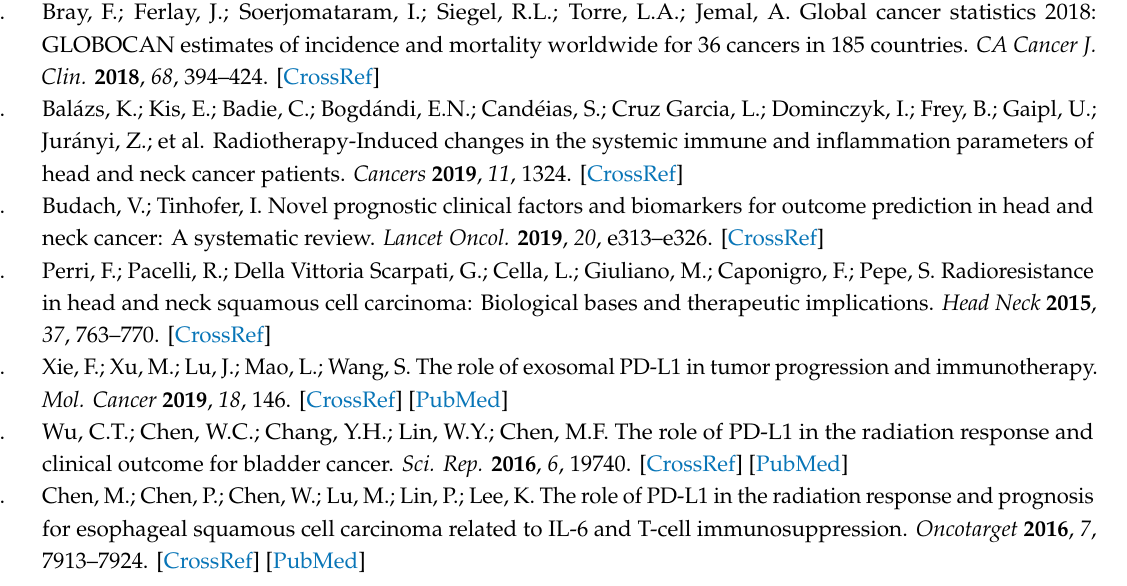
Figure S1 : The e ff ects of IPZ on the viability of HNSCC cells, Figure S2: The analysis of relationship between BBC3 and TP63 or JUN mRNA, Figure S3: The e ff ects of IPZ on nuclear localization of c-JUN in SAS cells, Figure S4: The relationship between KPNB1 expression and prognosis of di ff erent types of cancer patients, Figure S5: The e ff ects of IPZ on cell viability of lung adenocarcinoma A549 cells, Figure S6: The e ff ects of IPZ on proliferation and radiosensitivity of human hepatocellular carcinoma HepG2 cells, Figure S7: The e ff ects of KPNB1 knockdown on radiation-increased cell surface PD-L1 expression on HNSCC cells, Figure S8: The e ff ects of IPZ on proliferation and radiation-induced apoptosis of human umbilical vein endothelial cells (HUVEC). Supplementary